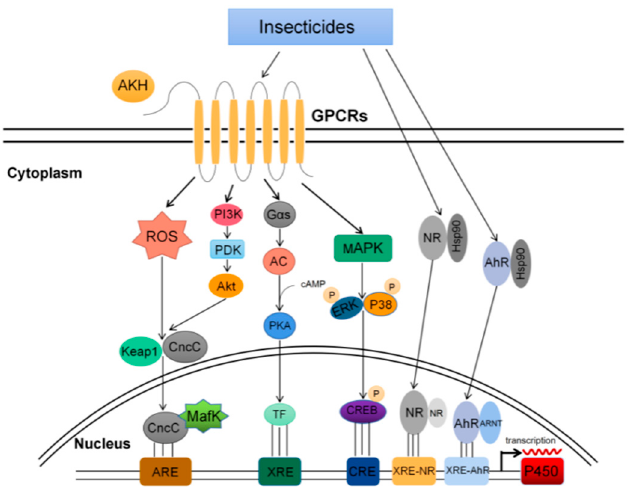
Figure 3. Model of the theoretical signalling pathway for insecticide resistance induced by insect P450s. Some insecticides can be sensed by the membrane receptor GPCR, which then stimulates downstream effectors to bind to specific sites in the cytoplasm and nucleus that trigger compensatory responses that affect P450 activity; other insecticides can diffuse into the cell and be transferred to the nucleus by NR or AhR in the cytoplasm binds to nuclear receptor sites. The black arrow indicates the cascade of effectors in the signalling pathway. AKH, adipokinetic hormone; GPCRs, G protein- couple receptors; ROS, reactive oxygen species; Keap1, Kelch-like ECH-associated protein 1; CncC, Cap‘n’ Collar isoform C; MafK, Musculoaponeurotic fibrosarcoma K; ARE, Antioxidant responsive element; PI3K, phosphoinositide-3-kinase; PDK, 3-phosphoinositide-dependent kinase; Akt, protein kinase B; Gas, G protein alpha unit which stimulates adenyl cyclase; AC, adenyl cyclase; cAMP, cyclic adenosine monophosphate; PKA, protein kinase A; TF, Transcription factor; XRE, xenobiotic response element; MAPK, mitogen-activated protein kinase; ERK, extracellular regulated protein kinase; P38, P38 mitogen-activated protein kinase; CREB, c-AMP response element binding protein; -P, phosphorylation; CRE, cAMP response element; NR, nuclear receptor; AhR, aryl hydrocarbon receptor; Hsp90, heat shock protein 90; ARNT, aryl hydrocarbon receptor nuclear translocator; XRE-NR, xenobiotic response element-nuclear receptor; XRE-AhR, xenobiotic response element-aryl hydrocarbon